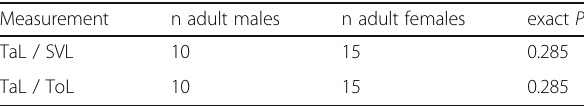
Table 5 Results of the Mann-Whitney U test for comparison of not normally distributed morphometric characteristics of blunt-nosed vipers from Cyprus Measurement